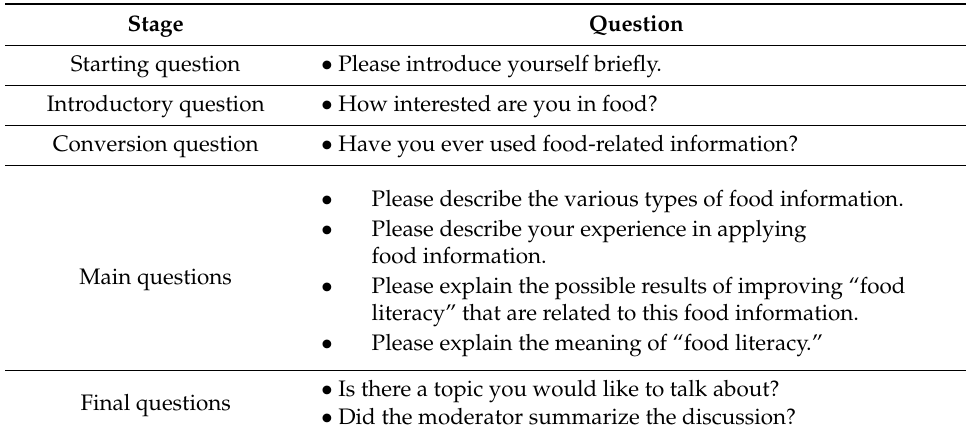
Table 1. Question list for focus group